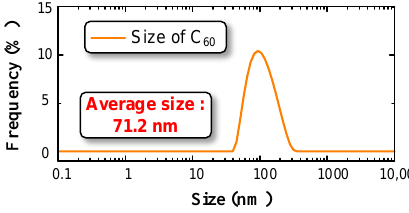
Figure 1. Size distribution of nano-titanium oxide (TiO 2 ) particles.